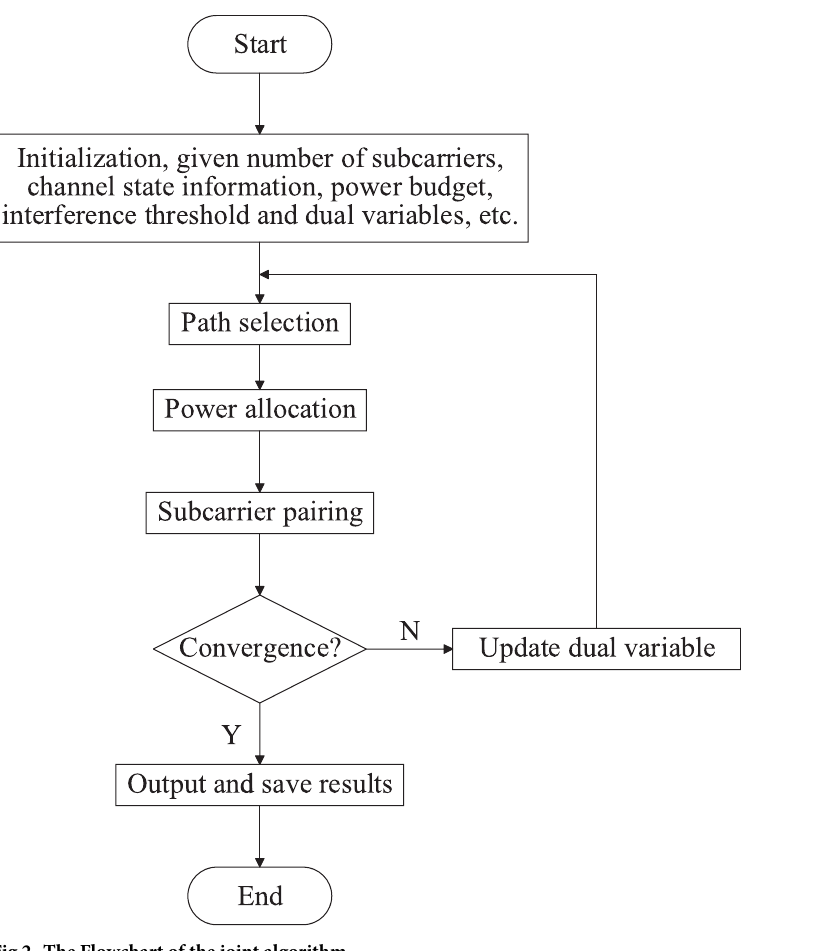
Fig 2. The Flowchart of the joint